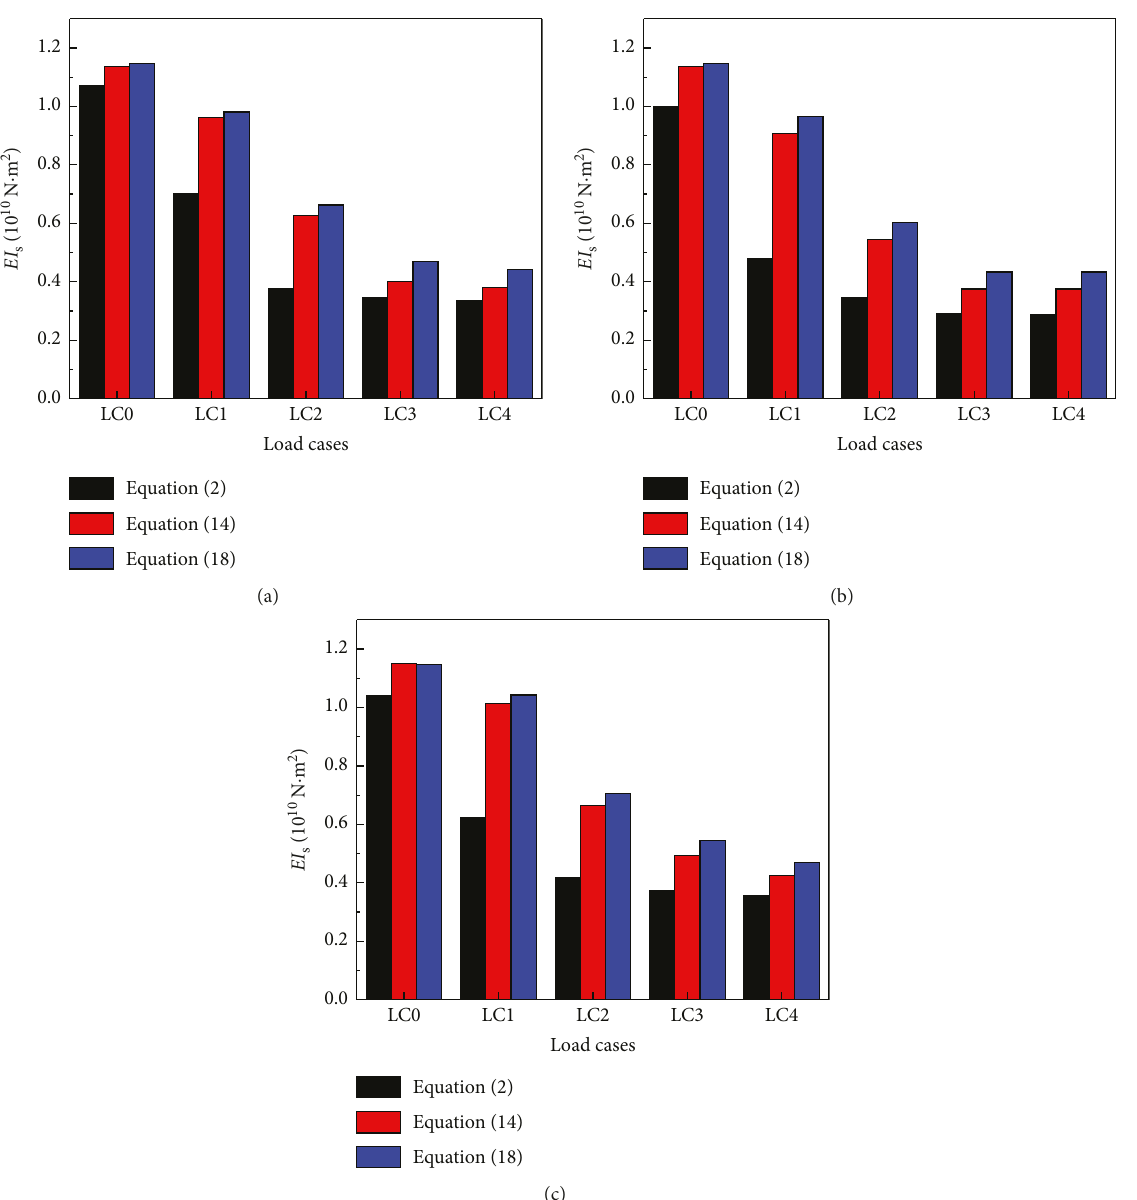
Figure 13: Comparisons of each equivalent flexural rigidity calculation method for test girder. (a) Girder Z1. (b) Girder Z2. (c) Girder